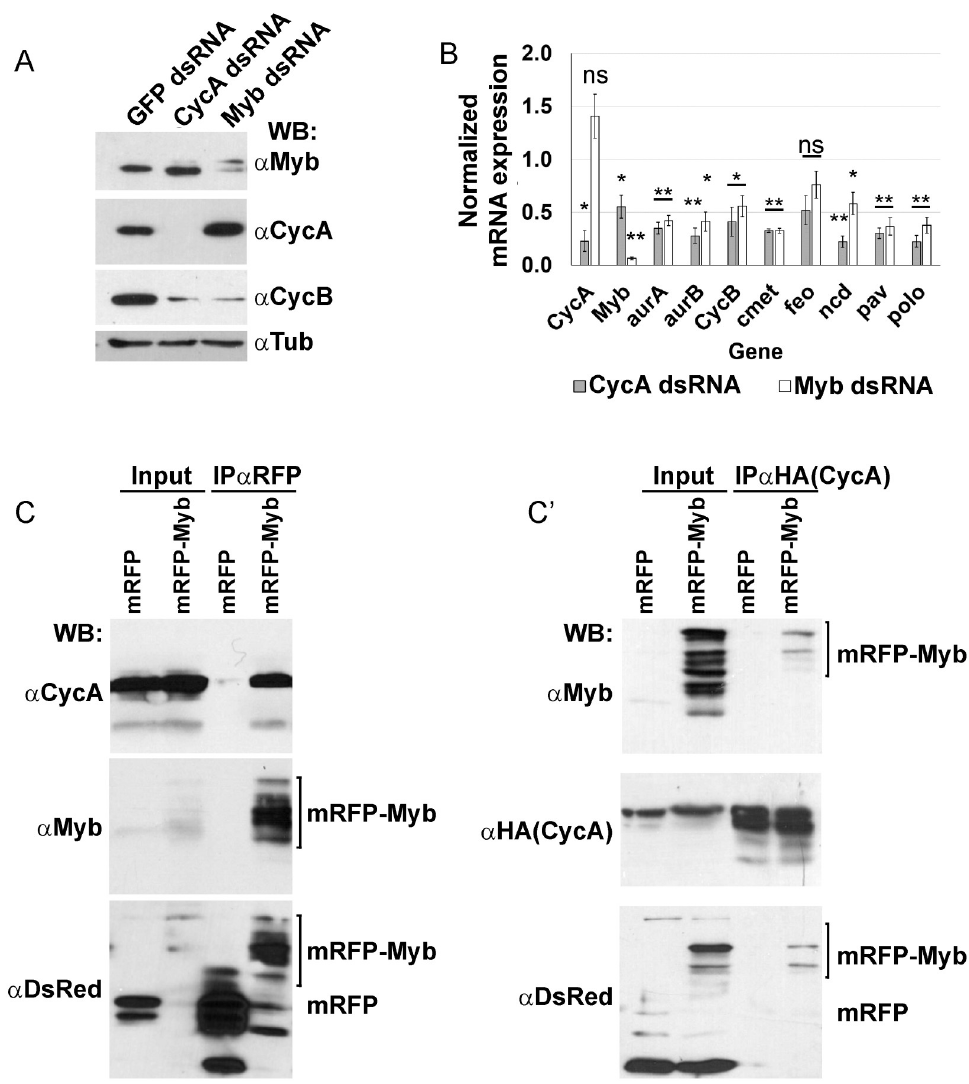
Fig 3. Myb induction of M phase gene expression is downstream of and dependent on CycA. (A) Cyclin B protein levels are reduced in CycA dsRNA and Myb dsRNA iECs. Western blot of S2 cell extracts after treatment with the indicated dsRNA and incubated with antibodies against CycA, Myb, CycB, and alpha-Tubulin (loading control) (N = 3, a representative blot is shown). (B) RT-qPCR analysis of select MMB target gene expression in CycA dsRNA and Myb dsRNA iECs. Values shown are the mRNA levels in knockdown cells divided by those in control GFP dsRNA cells (mean and S.E. M. for N = 3 biological replicates, � —p < 0.05, �� —p < 0.01, ns—not significant). (C) CycA and Myb proteins interact in vivo . Larvae expressing UAS-CycA and either UAS-mRFP or UAS-mRFP-Myb were immunoprecipitated with nanobodies against mRFP and then Western blotted (WB) with antibodies against CycA, Myb, and DsRed (detects mRFP) (representative blot, N = 3), (C’) Reciprocal IP. Larvae expressing UAS-CycA-HA and either UAS-mRFP or UAS- mRFP-Myb were immunoprecipitated with antibodies against HA and then Western blotted (WB) with antibodies against Myb, HA to detect CycA:HA, and DsRed (representative blot, N = 3).